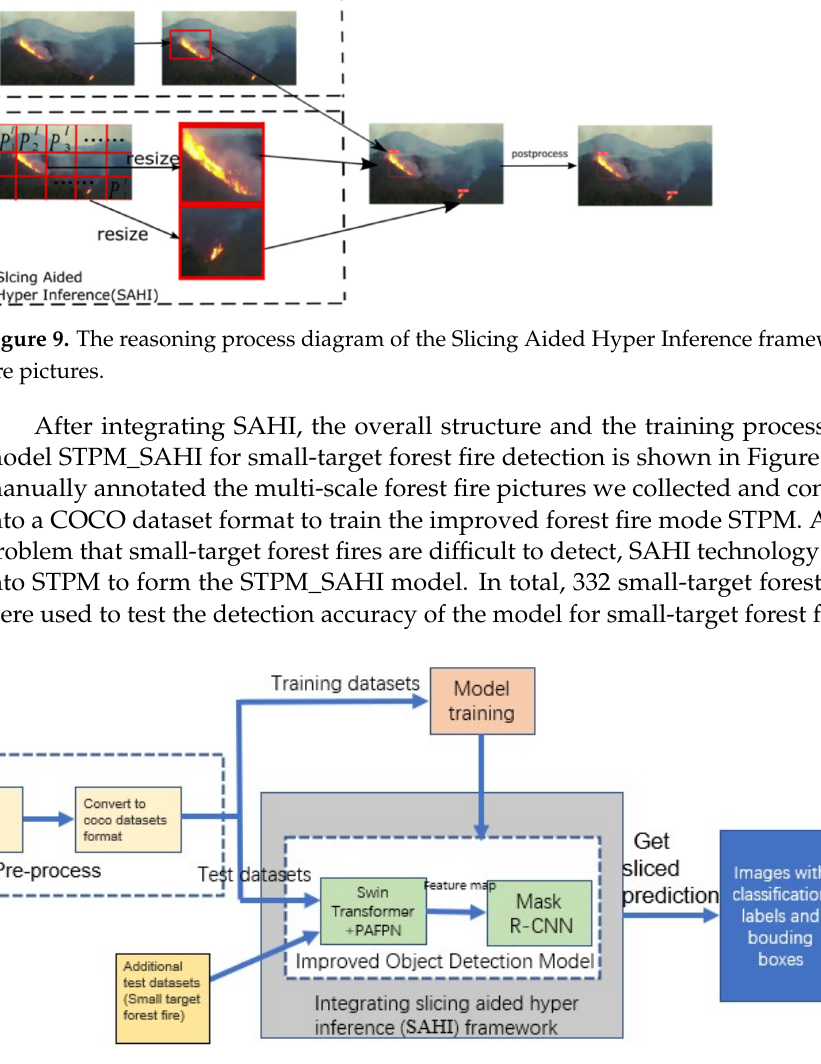
Table 2. Experimental conditions.